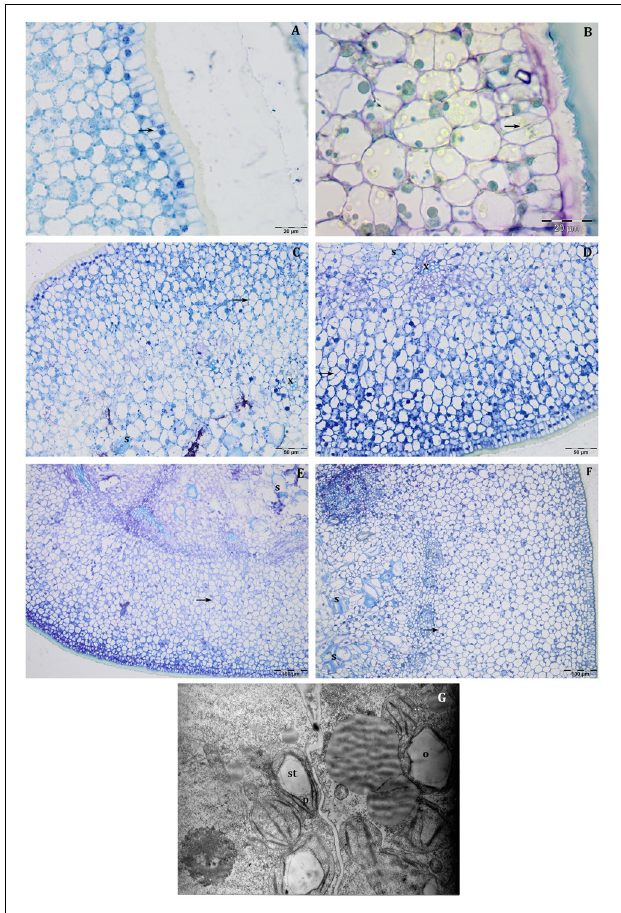
FIGURE 3 | Semi-thin sections at 50 DAF of Leccino (A,C,E,G) and Frantoio (B,D,F,H) fruits in light (A,B,E,F) , and shade (C,D,G,H) conditions. Oil drops were evident (as little dark spheres) in some mesocarp cells and the endocarp was occupied by sclerified clusters (E–H) . (A–D) are stained with osmium, while (E–G) are stained with PAS reaction and (H) is stained with toluidine